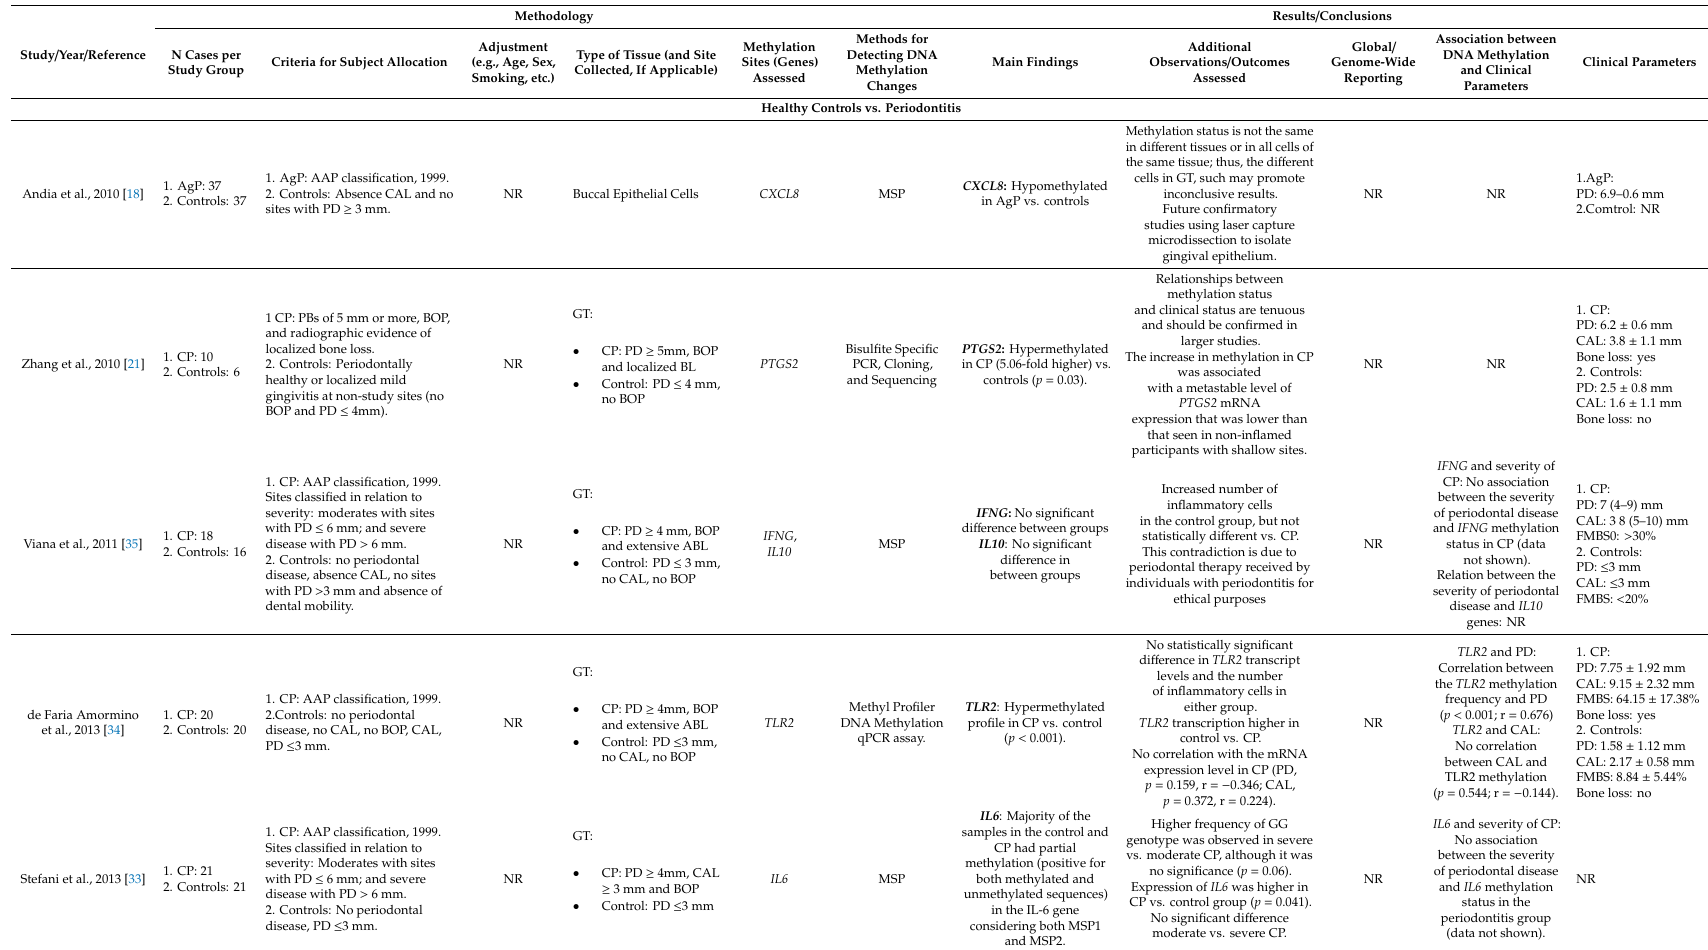
Table 2. Description of epigenetic testing and